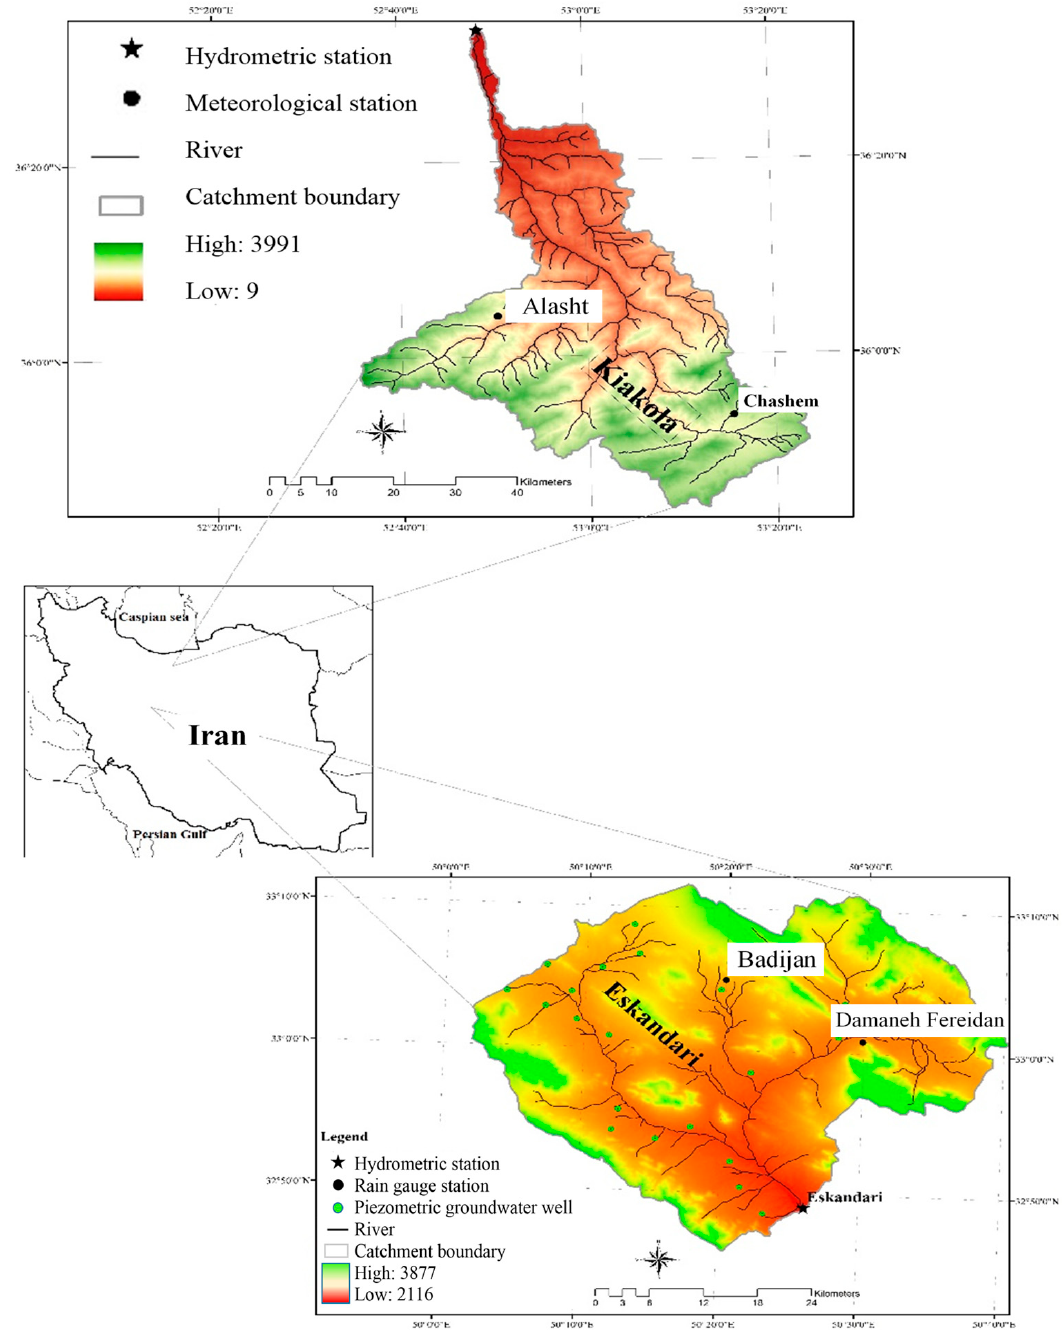
Figure 1. Location of study areas in Iran.